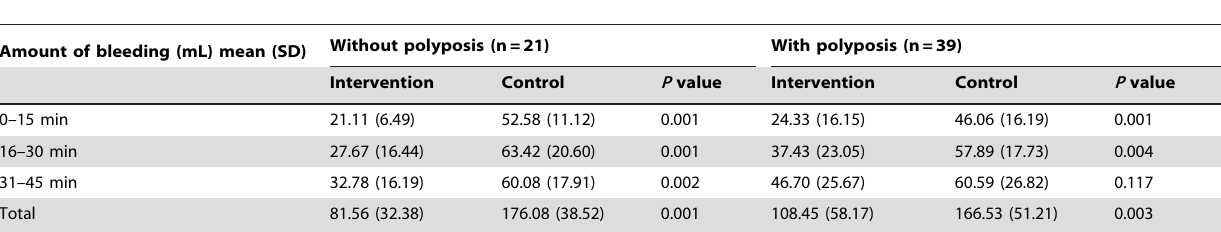
Table 6. Effect of tranexamic acid plus phenylephrine versus phenylephrine alone on amount of bleeding by duration of time and with or without polyposis using Fisher exact